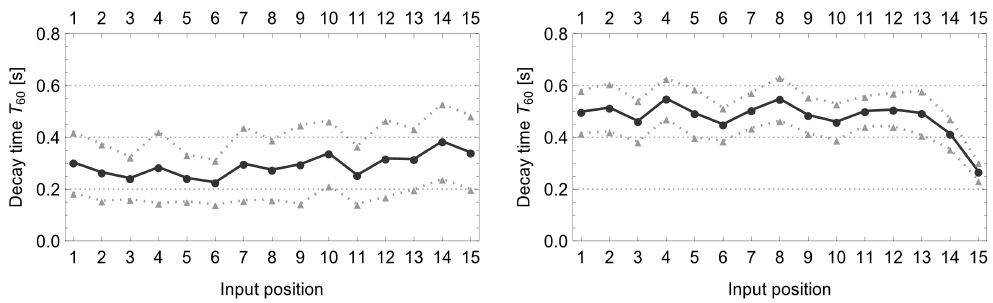
Figure 2. Measured T60 decay times for a piano soundboard in two production stages at 14 string/bridge impact points. Circles indicate mean values over all microphone recordings, triangles represent (mean ± standard deviation). ( Left ) the raw soundboard, ( right ) the finished soundboard. At the very first stage of production (left) T60 ∼ 0.3, while after gluing the soundboard to the piano rim ( right ) T60 raises up to T60 ∼ 0.6 s.